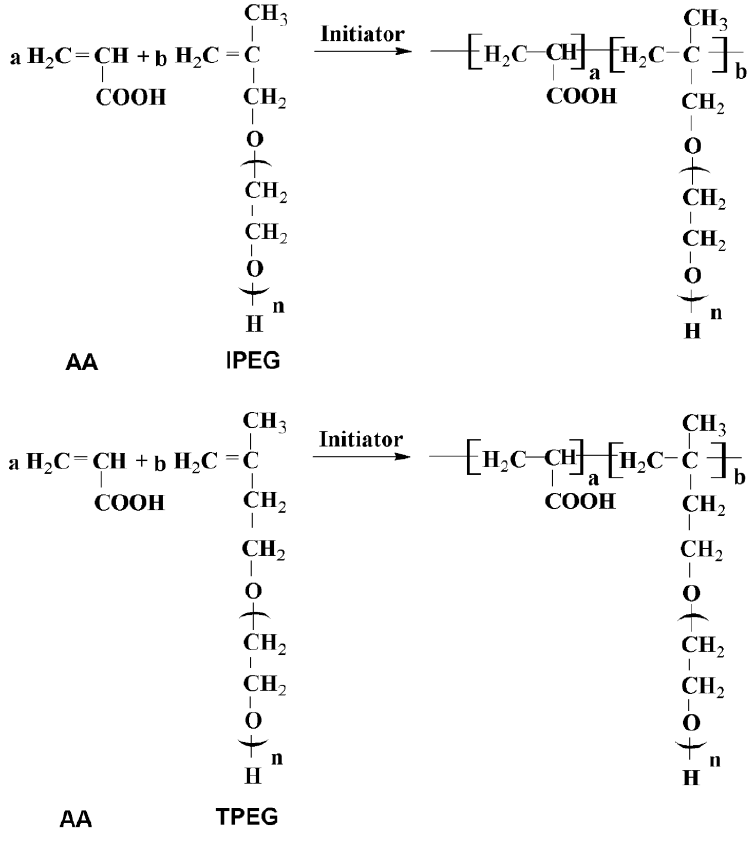
Figure 1. Schematic diagram of the synthesis of polycarboxylate superplasticizer (PCE).